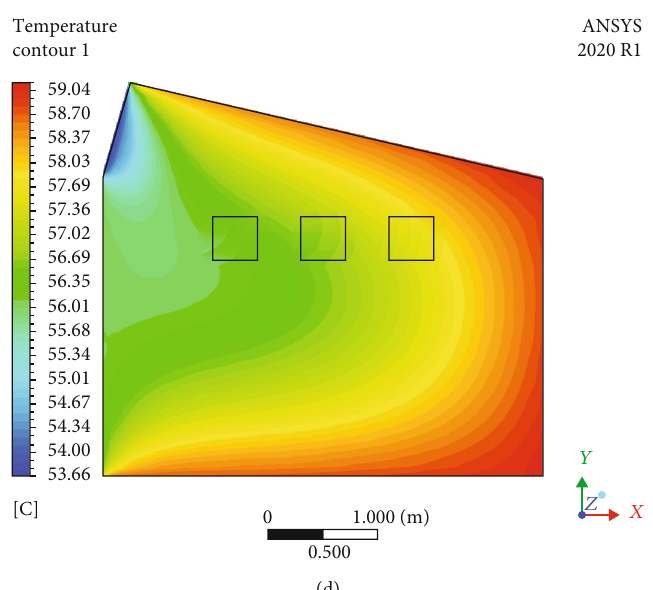
Figure 7: Temperature distribution inside the greenhouse dryer according to the horizontal and vertical planes for (a, b) day-1 and (c, d) day- 2 at 13h :00.